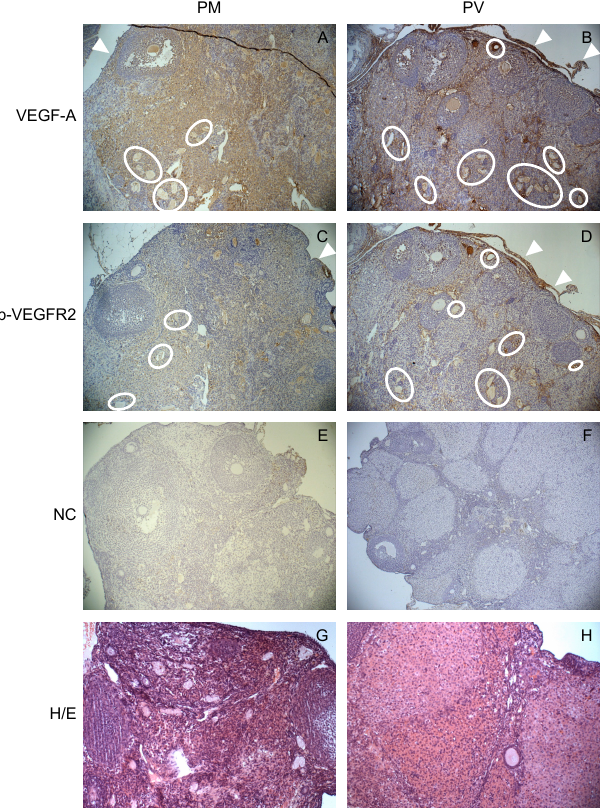
Figure 2. Tissue localization of VEGF-A and p-VEGFR2 in mouse ovaries. Representative images of VEGF-A ( A , B ) and p-VEGFR2 ( C , D ) immunoreactivity in post-reproductive multiparous (PM) and virgin (PV) ovaries. Negative controls (NC; E , F ) and H&E staining ( G , H ) are presented. White circles indicate the presence of areas with small vessels; white arrowheads indicate the presence of ovarian surface epithelium, which appear to be multi-layered in PV ovaries ( B , D ). Magnification: ×